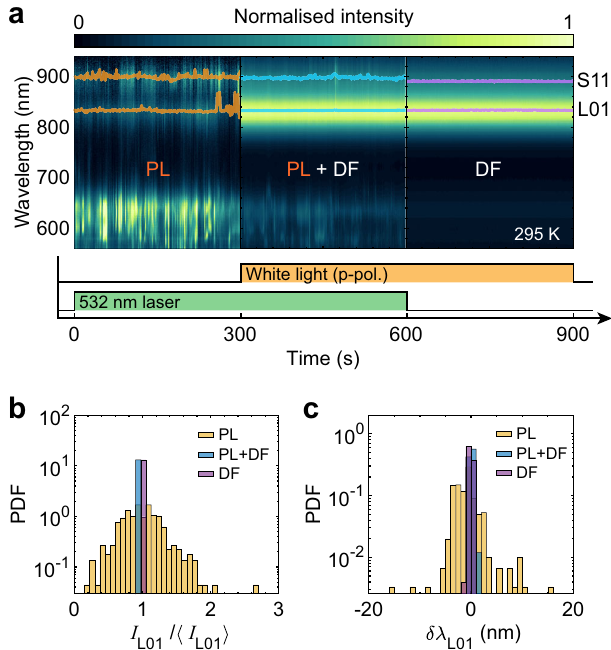
Fig. 4 Blinking PL with stable dark fi eld. a Spectral time series from an individual nanojunction under sequential illuminations with 532 nm laser alone (PL), both 532 nm laser and white light (PL + DF, normalized by illumination spectrum) and white light alone (DF, normalized by illumination spectrum). The positions of maximum emission close to the L01 and S11 modes are shown as orange, blue, and purple traces for the PL, PL + DF, and DF regions, respectively. b , c Probability density functions (PDFs) for the relative L01 peak intensity ( b ) and wavelength shift ( c ) extracted from the PL (orange), DF (purple), and DF + PL (blue) regions in a . The DF + PL (blue) area in b are slightly offset away from the value of 1 to show it clearly. Experimental parameters: objective numerical aperture = 0.8; laser power density ~ 45 μ W μ m − 2 ; white light is p-polarized; exposure time = 1 s, room